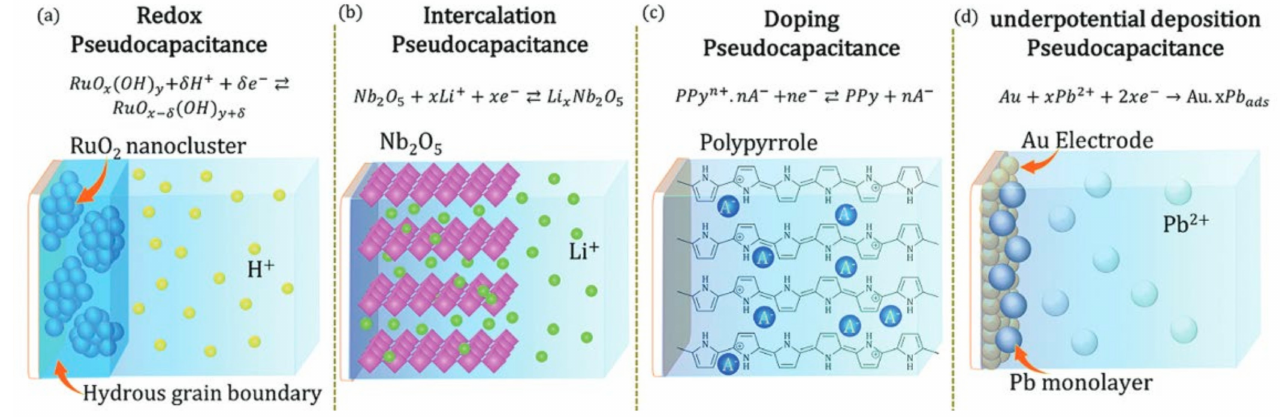
Figure 2. Scheme of different types of redox reactions giving rise to pseudocapacitance. Reproduced with permission from [24].